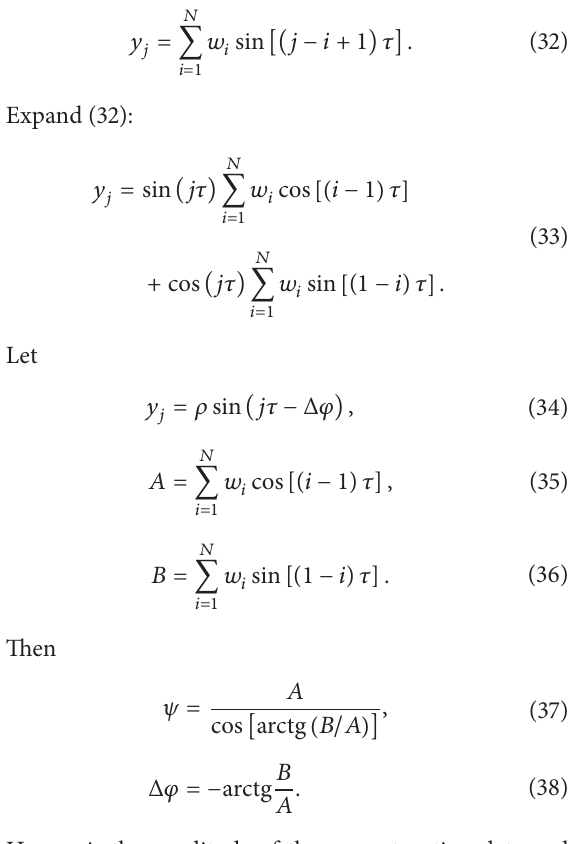
Figure 11: The diagram of software